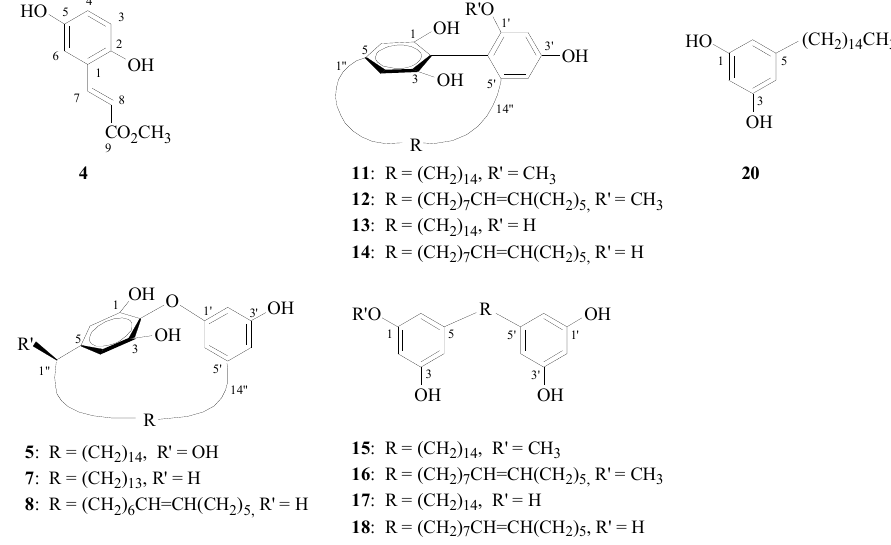
(a) Values were mean ± SD (n = 3–8). MCF-7 = human breast tumor cell line; NCI-H460 = human lung tumor cell line; SF-268 = human entral nervous system